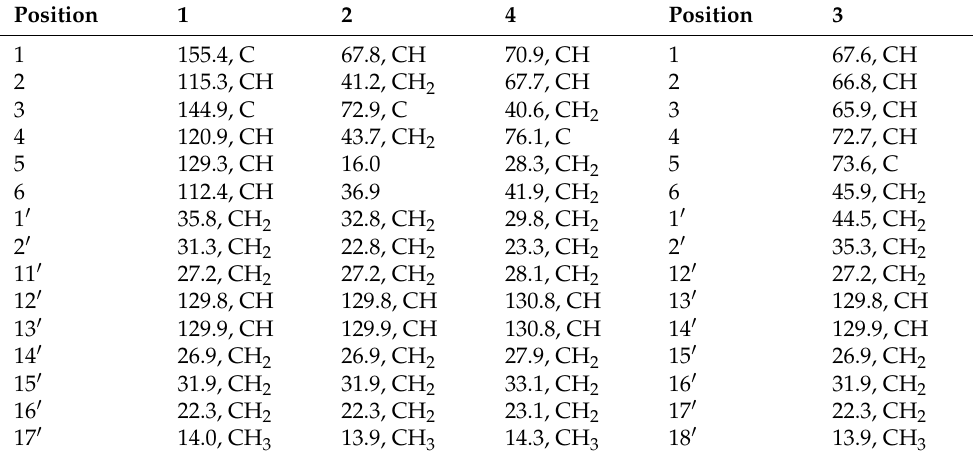
Table 1. 13 C NMR (400 MHz, δ C , Type) spectral data for compounds 1–4 .